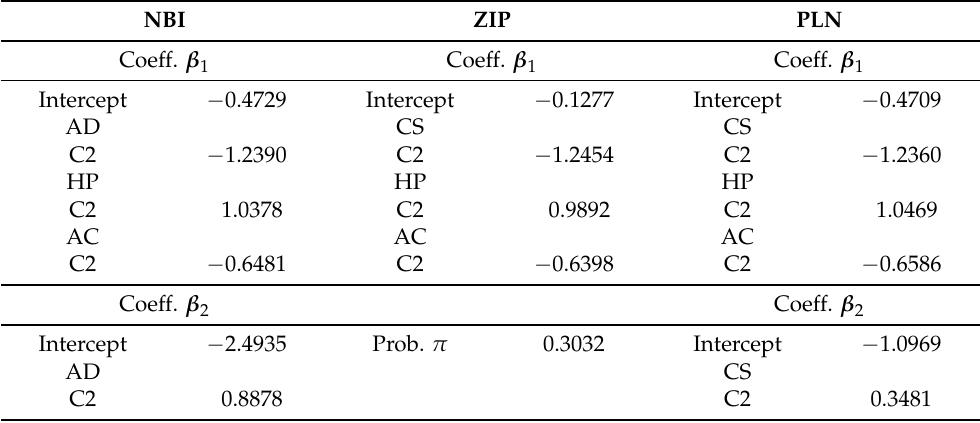
Table 2. Parameter estimates of the ZIP regression model and the NBI and PLN regression models with varying